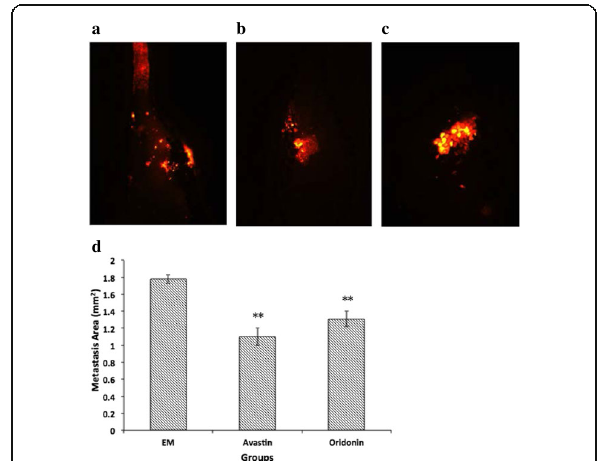
Fig. 10 Tumour metastasis in xenograft zebrafish after 7 d exposure to EM, Avastin, and oridonin. a blank control group (EM); b positive control group (Avastin); c the group (oridonin); d Metastasis area comparison. The asterisks indicate statistically significant differences from the control group (** P < 0.01)